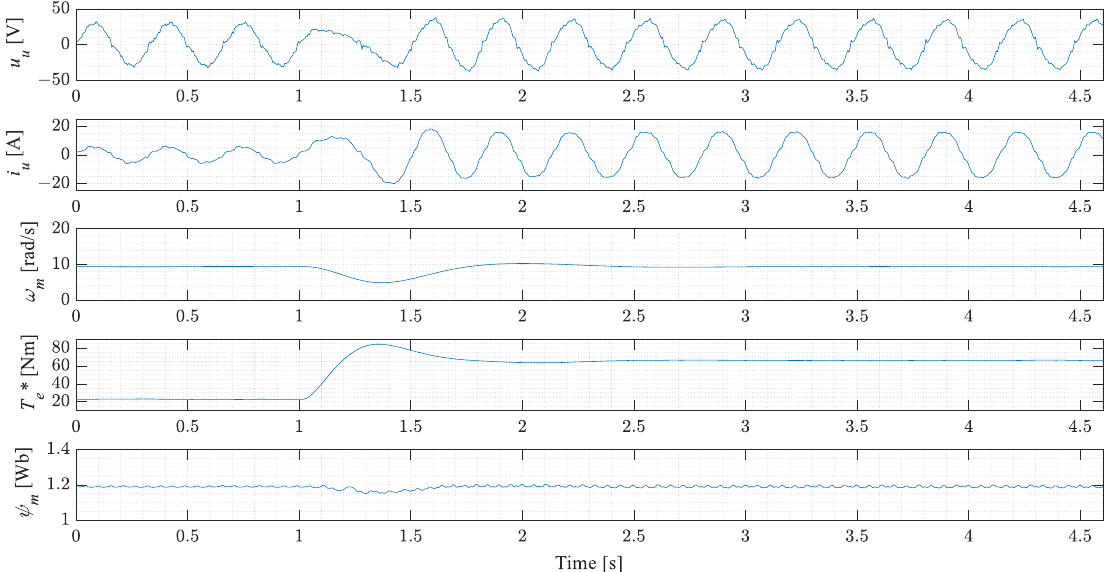
Figure 12. Experimental results of the cycloconverter drive during load torque change at 10% of rated machine speed.